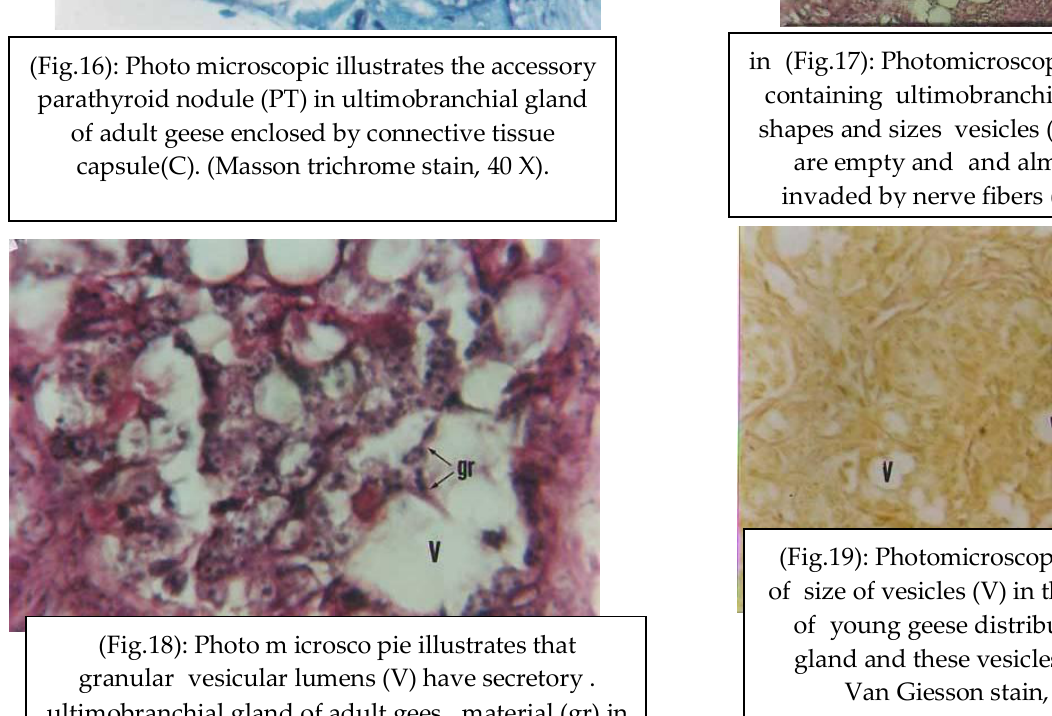
material (gr) in ultimobranchial gland of adult gees.